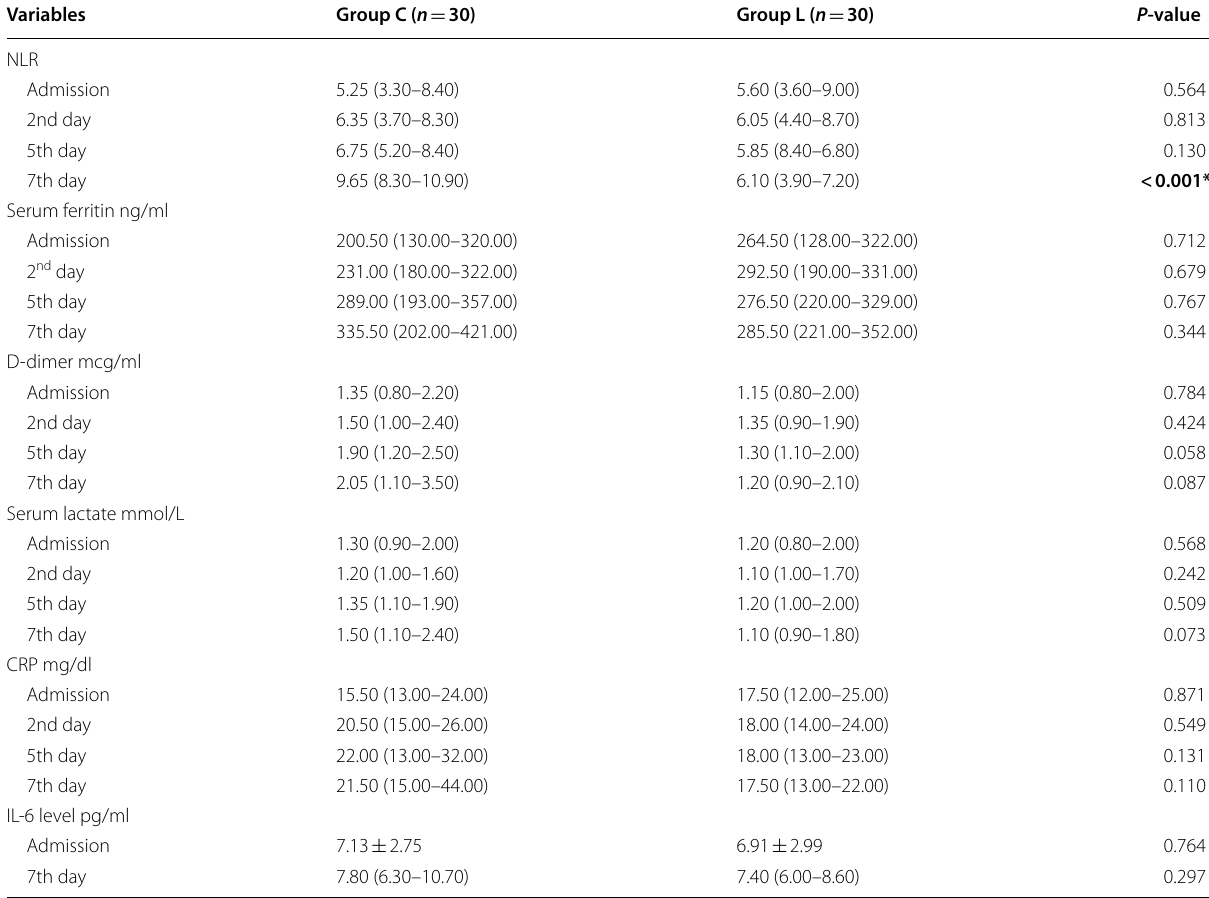
Data are presented as median and IQ (interquartile range) and mean NLR Neutrophil/lymphocyte ratio, CRP C-reactive protein Group C (standard enteral nutrition) and Group L (fish-oil-based intravenous lipid emulsion)